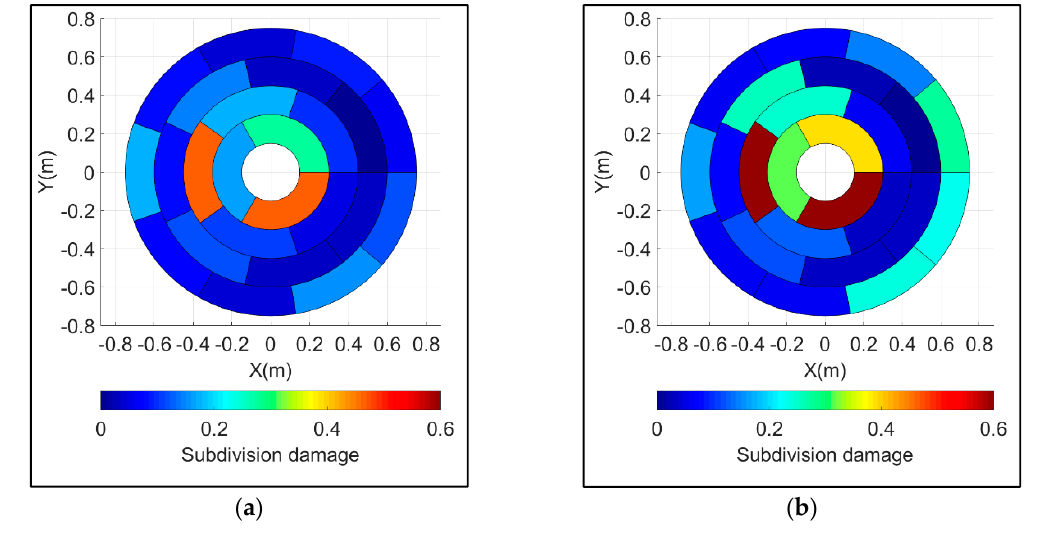
Figure 19. Test 04 subdivision damage number: after 1000 waves Test 04_A ( a ) and after 3000 waves Test 04_B ( b ). The current propagation in this set of figures is from right to left.